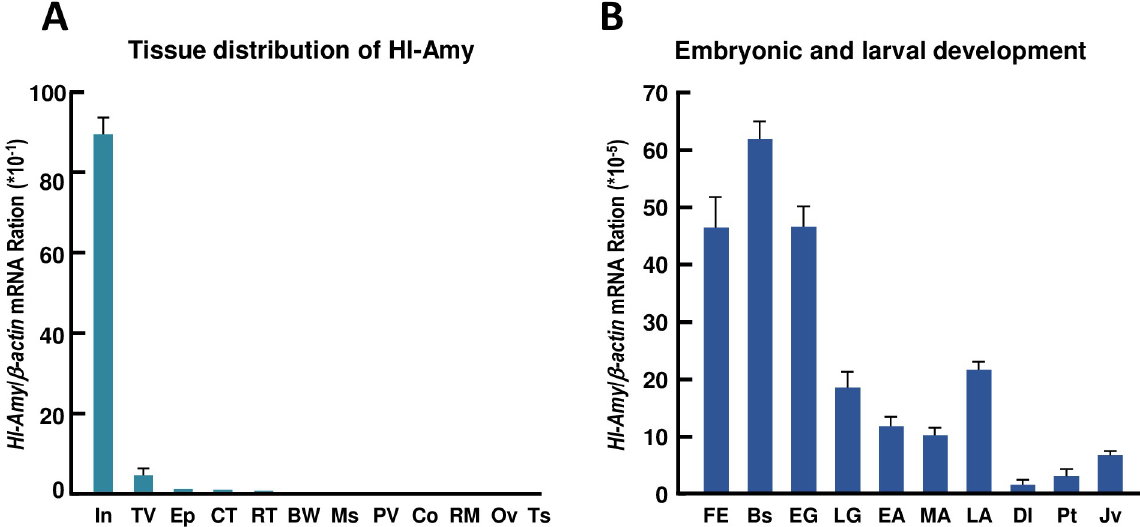
Fig 3. Tissue distribution and embryonic and larval developmental expression of Hl-Amy mRNA. A : Expression profiles of Hl-Amy mRNA in different tissues of H . leucospilota , including intestine (In), transverse vessel (TV), esophagus (Ep), cuvierian tubules (CT), respiratory trees (RT), body wall (BW), muscle (Ms), polian vesicle (PV), coelomocytes (Co), rete mirabile (RM), ovary (Ov) and testis (Ts). B : Expression profiles of Hl-Amy mRNA in embryonic and larval development of H . leucospilota , including fertilized egg (FE), blastula (Bs), early gastrula (EG), late gastrula (LG), early auricularia (EA), mid auricularia (MA), late auricularia (LA), doliolaria (Dl), pentactula (Pt) and juvenile (Jv). The data presented are expressed as the mean ± S.E with three biological replicates. https://doi.org/10.1371/journal.pone.0239044.g003 PLOS ONE | https://doi.org/10.1371/journal.pone.0239044 September 15,